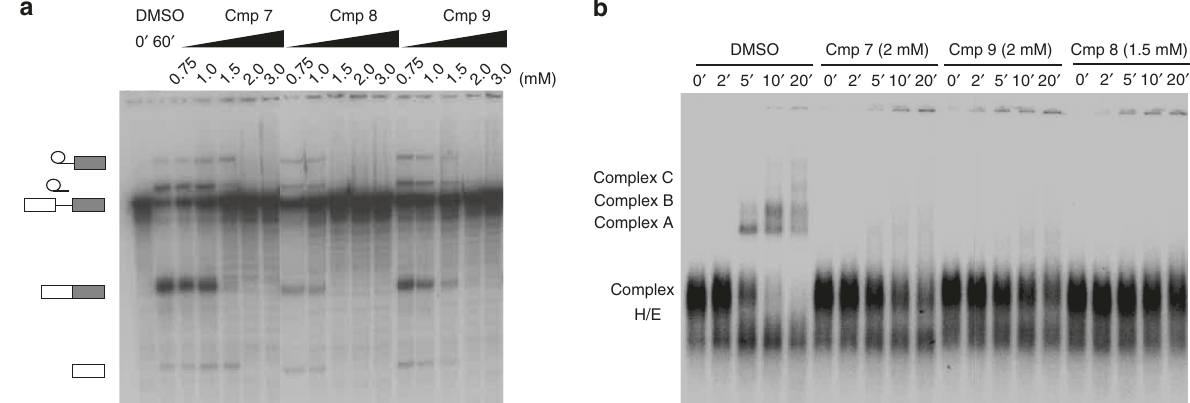
Fig. 5 In vitro splicing assay of IgM pre-mRNA with 7,8-dimethoxyperphenazine (Cmp7), Cmp8 and Cmp9. a 7,8-dimethoxyperphenazine (Cmp7), Cmp8 and Cmp9 abolish splicing of IgM pre-mRNA at 2 mM, 1.5 mM and 2 mM respectively. b Separation of spliceosomal complexes on an agarose gel. For Cmp7, splicing inhibition ( a and b ) was replicated in three independent experiments, and for Cmp8 and Cmp9, it was performed once. The uncropped gel images are included in the Source Data fi le.